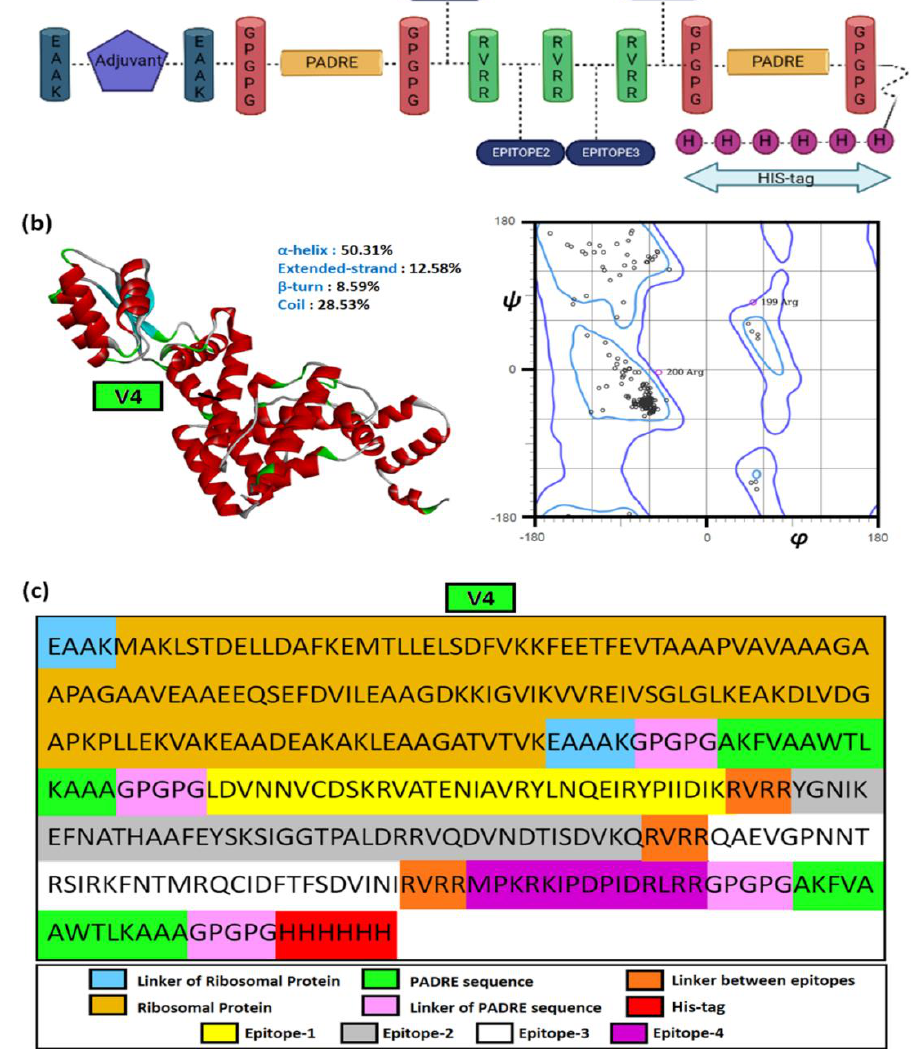
Figure 4. The vaccine construct . ( a ) The general structural outline of the vaccine constructs, ( b ) the structure of vaccine construct 4 (V4) with secondary structural components and corresponding Ramachandran plot, and ( c ) the detailed structural constituents of V4.